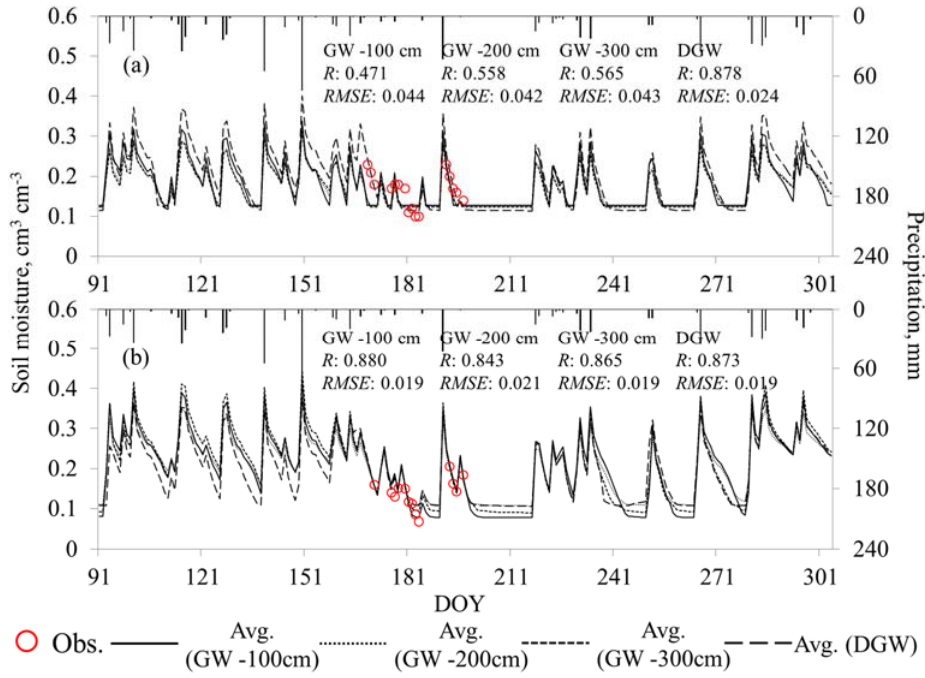
Figure 9. Observed (ESTAR) and ensemble averaged root zone soil moisture dynamics using FGW and DGW data assimilation schemes: ( a ) airborne sensing scale (800 m × 800 m) at LW 13 site; and ( b )